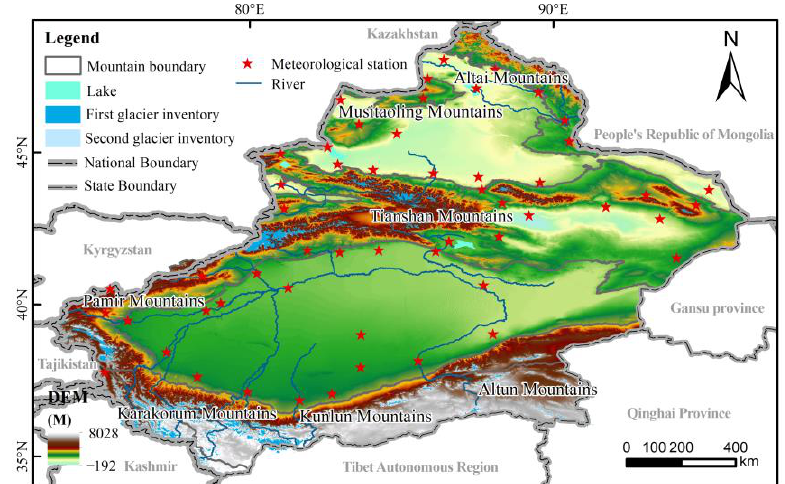
Figure 1. Location of the study